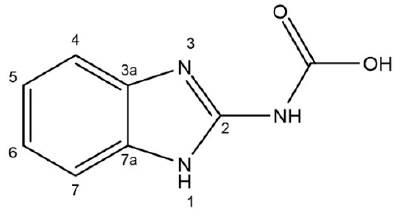
Figure 2. The structure of benzimidazole carbamate molecule.